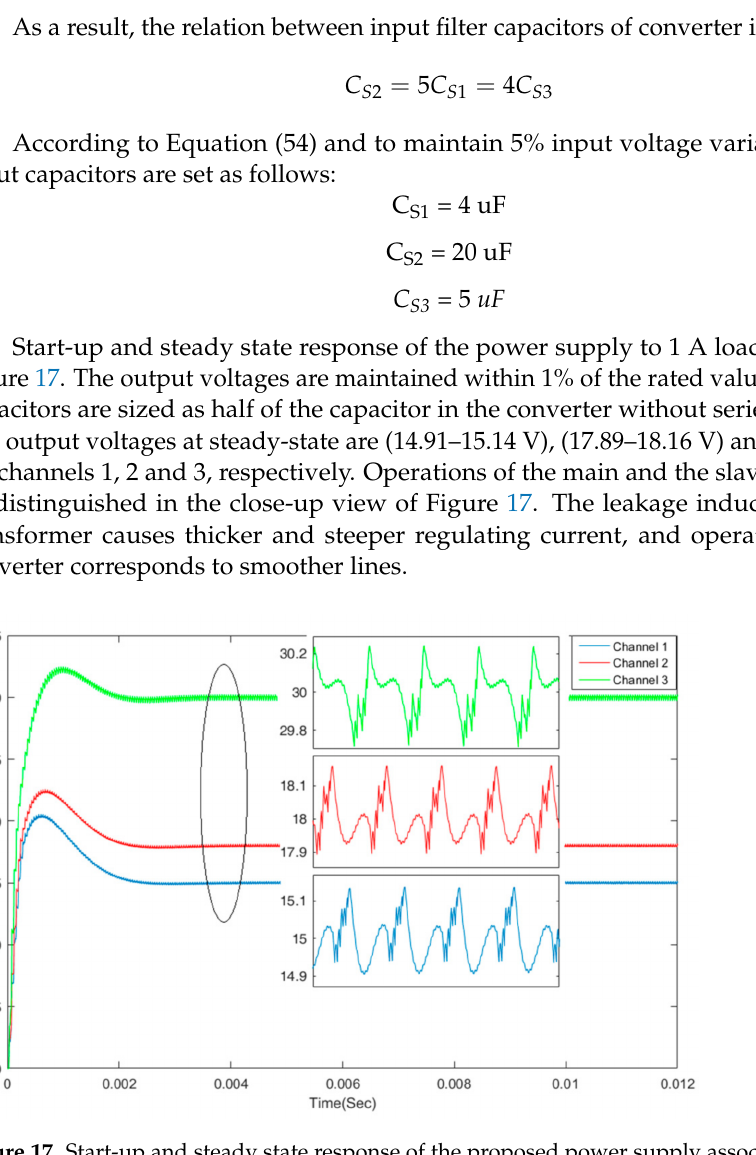
Figure 17. Start-up and steady state response of the proposed power supply associated with channel output